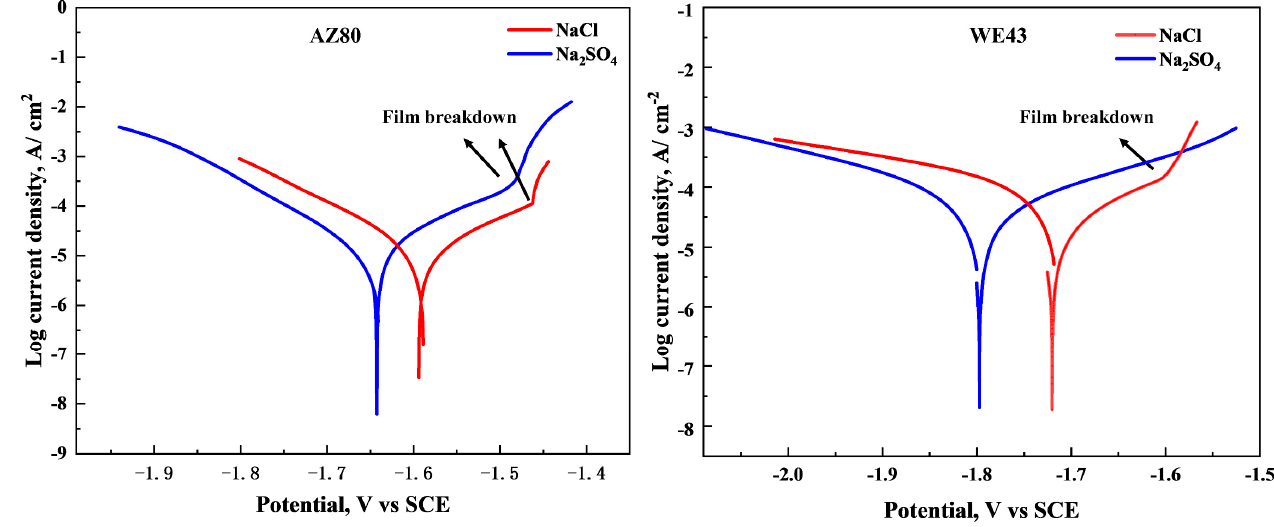
Figure 10. Comparison of polarization curves of WE43 and AZ80 alloys in 0.6 M NaCl and Na 2 SO 4 solution. The anodic and cathodic polarization curves were scanned from the OCP separately. Table 3. The fitting result of the AZ80 cathode polarization curve.